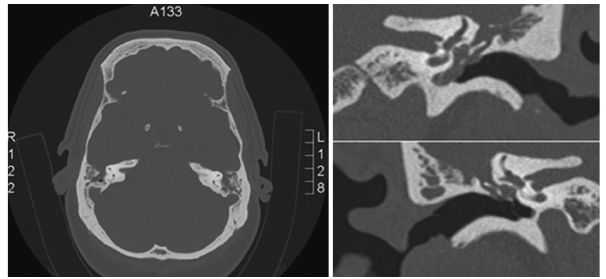
Figure 1: Axial and coronal CT images showing the tegmen